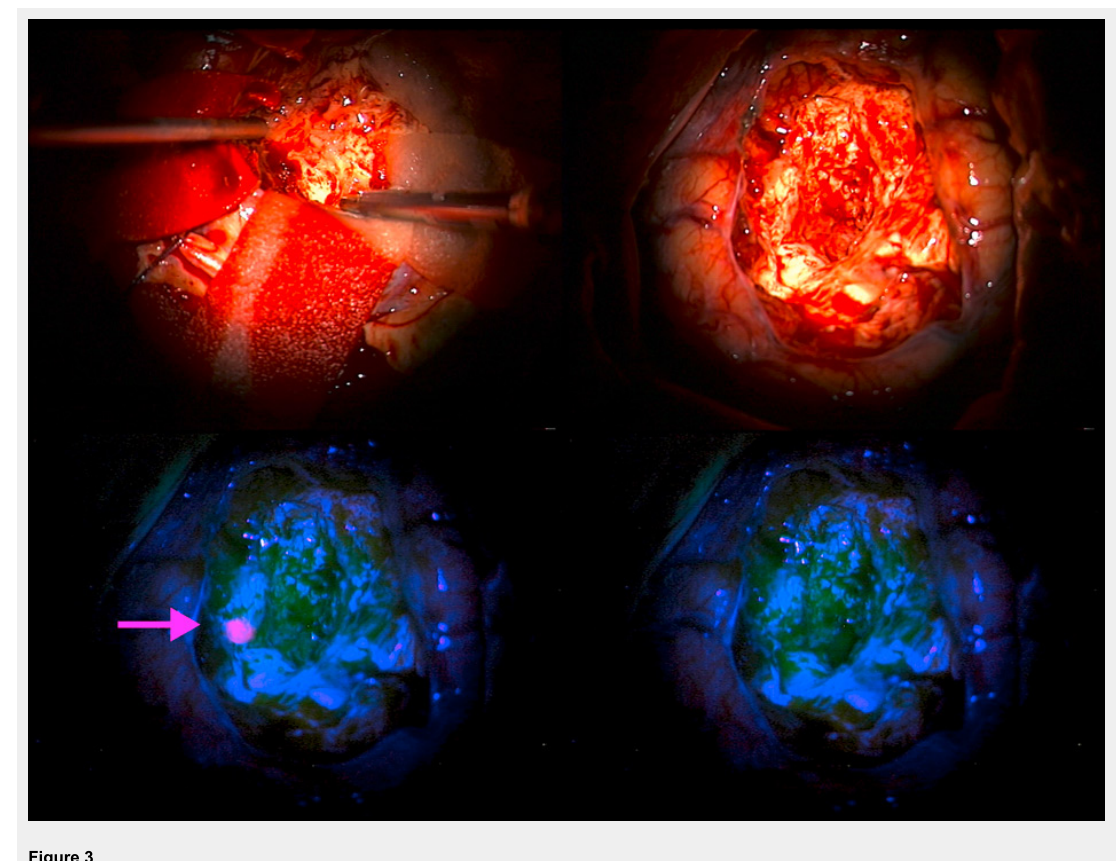
Figure 3 The oral prodrug 5-ALA identifies tumour tissue in surgery for glioblastoma. Top left: intraoperative view during tumour resection. Top right: surgical site after removal of all tumour tissue as seen in white light microscopy. Bottom left: upon switching to microscopic blue light a small patch of remaining tumour tissue can be seen thanks to 5-ALA fluorescence (arrow). Bottom right: surgical site after removal of all fluorescent tumour.